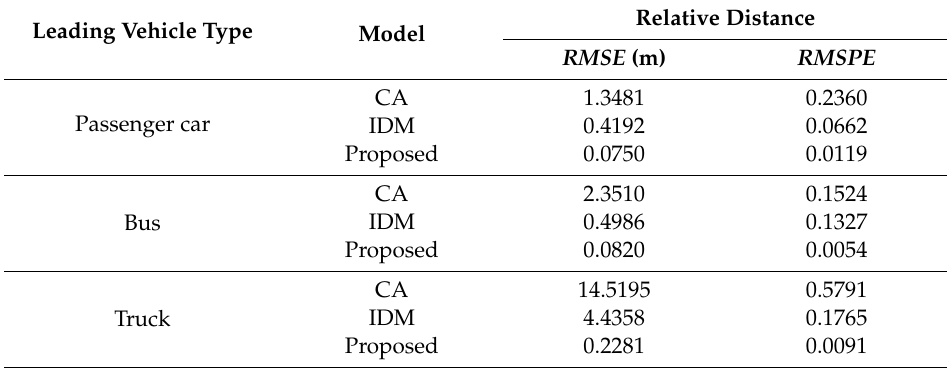
Table 5. Accuracy comparison between existing models and the proposed model.